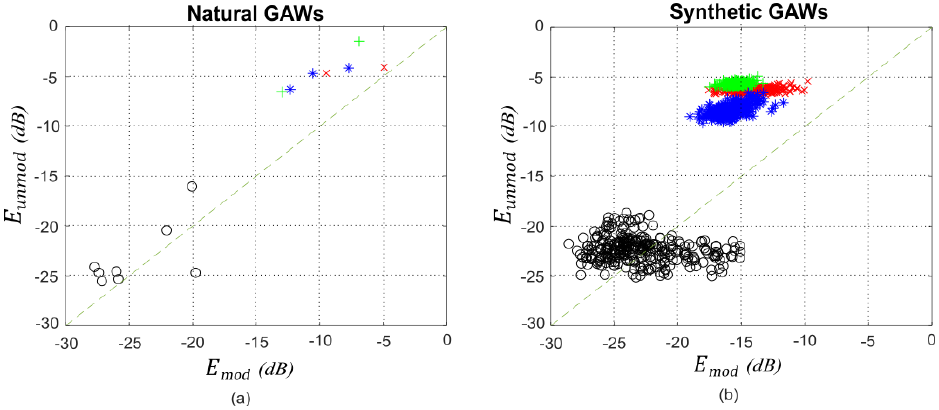
Figure 7. Scatter plots of the modelling errrors vocal fry GAWs and other types of GAWs: ( a ) natural and ( b ) synthetic GAWs. Table 1. Sensitivities, specificities and accuracies of classification between vocal fry and euphonic GAWs with 95% confidence interval (CI).